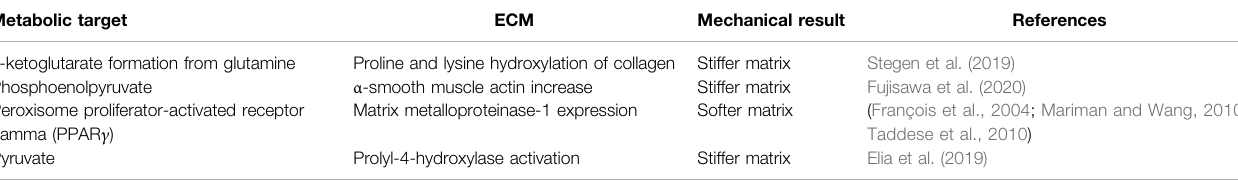
TABLE 2 | Metabolic pathways regulating ECM